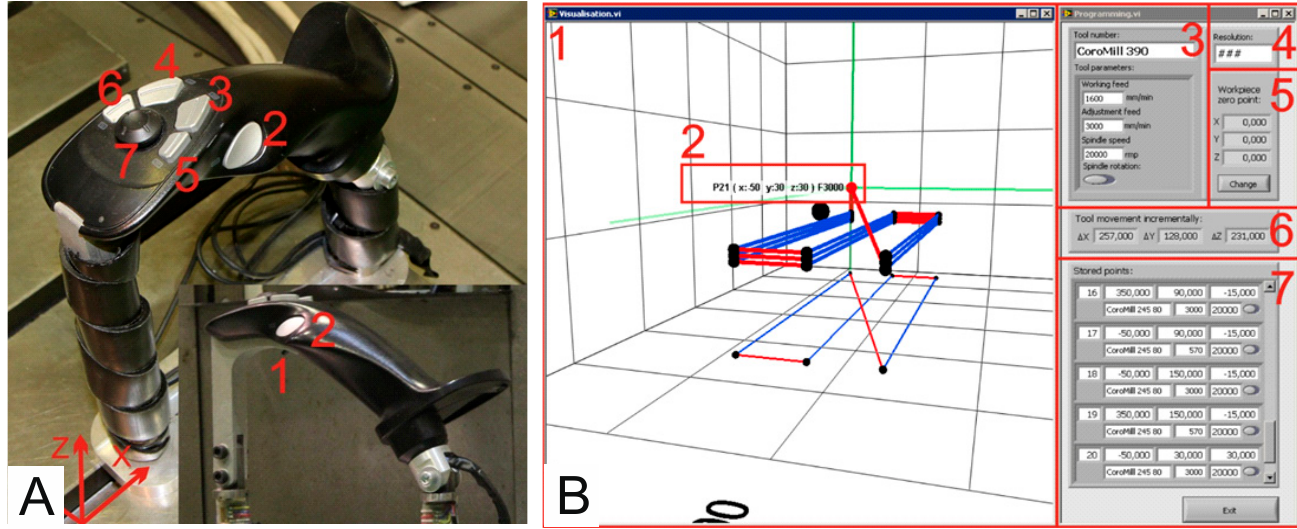
Figure 12. ( A ) Description of the function buttons of the main lever: 1. Safety button (when pressed, it enables the machine to move); 2. slowing down the motion of the machine; 3. saving positions; 4. deleting positions; 5. changing the motion axis; 6. changing the feed rate of the programmed track (working feed/changeover feed); 7. four-component controller for discrete movement on the X and Y axes. ( B ) Subprogram window for manual programming of a CNC machine tool: 1. Visualization window for displaying the saved track; 2. tool position in the object system along with speed; 3. tools and their parameters; 4. change of accuracy; 5. start of the object system; 6. additional display of incremental tool displacement; 7. saved points with parameters.